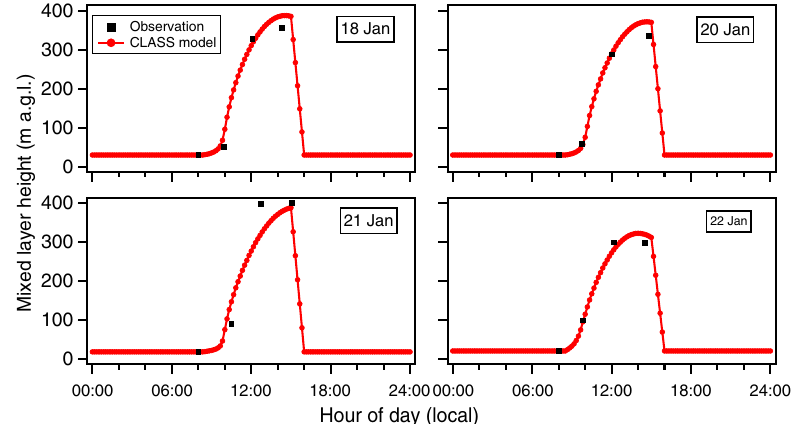
Figure B2. Evolution of the ML height with time (starting at 08:00LT) on the 4 flight days in Episode 1. The observational constraints are shown as black circles, where the first point comes from nearby balloon sonde measurements and the last three from the P3-B vertical profiles.